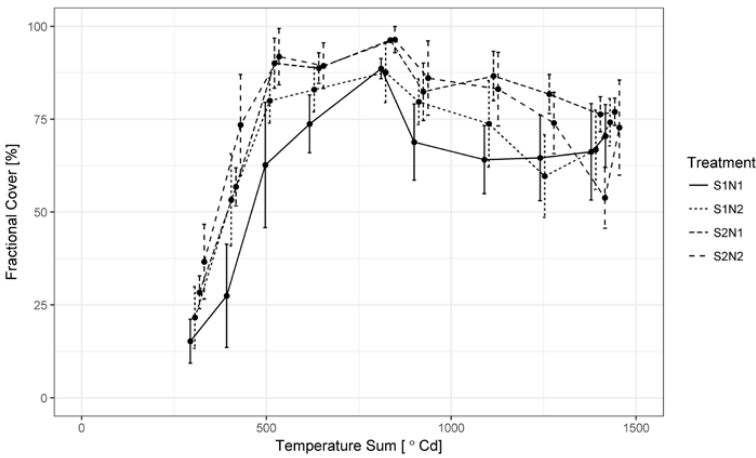
Figure 3. Green and Brown LAI development over the course of the growing season 2016. Error bars show standard deviation.